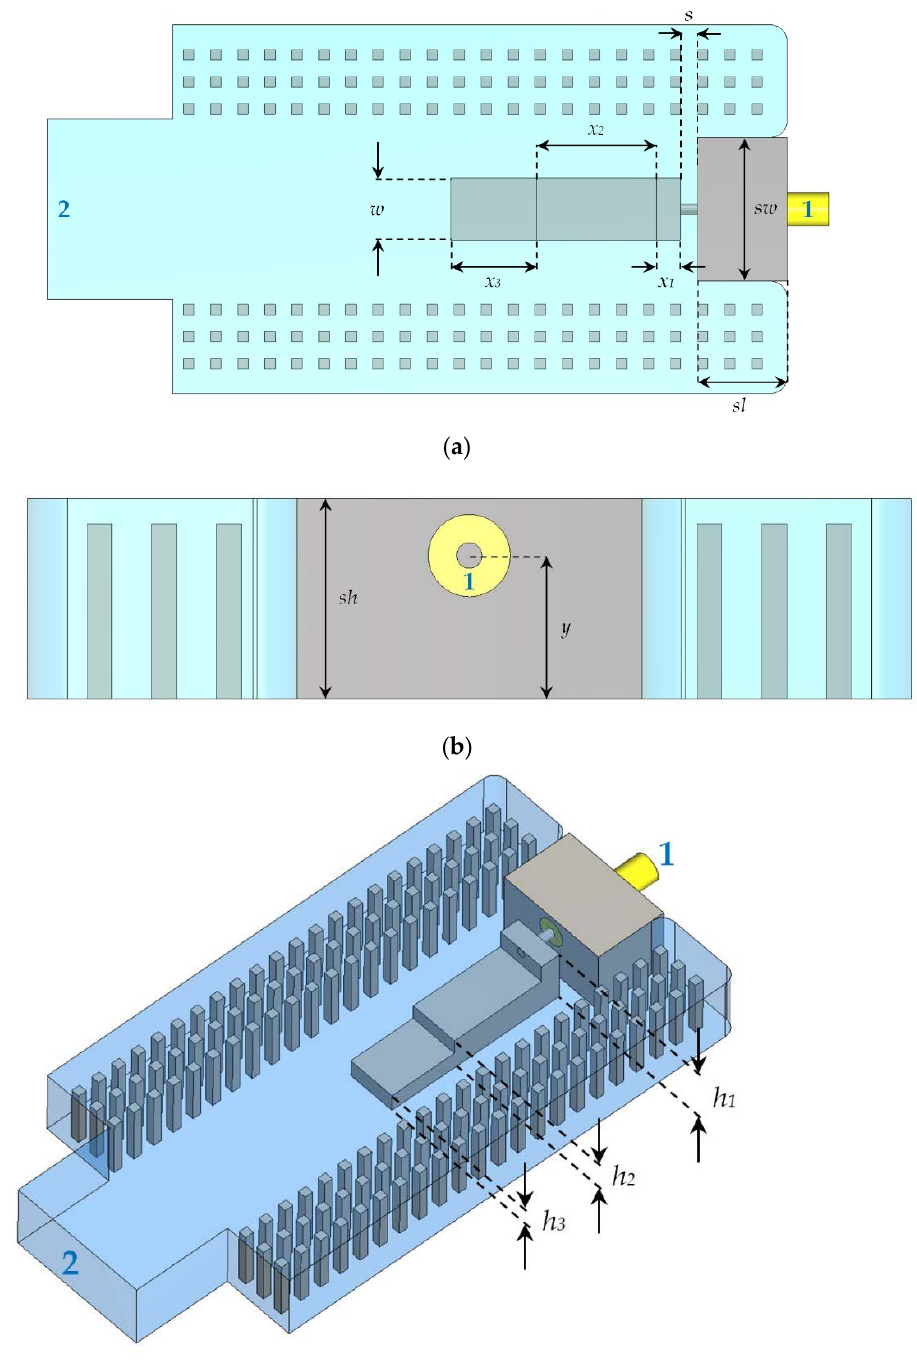
Figure 4. Coaxial-to-GGW IB transition geometry. ( a ) Top view. ( b ) Back view. ( c ) 3D view.